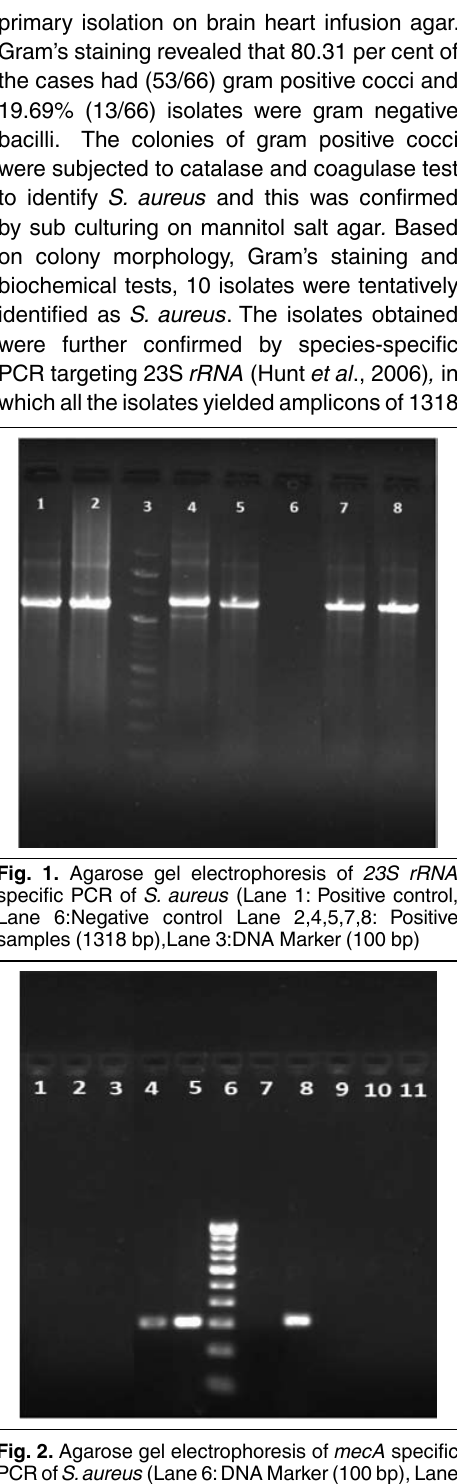
Fig. 2. Agarose gel electrophoresis of mecA specific PCR of S. aureus (Lane 6: DNA Marker (100 bp), Lane 4 and 5: Positive samples (303 bp), Lane 7: Negative control Lane 8: Positive control